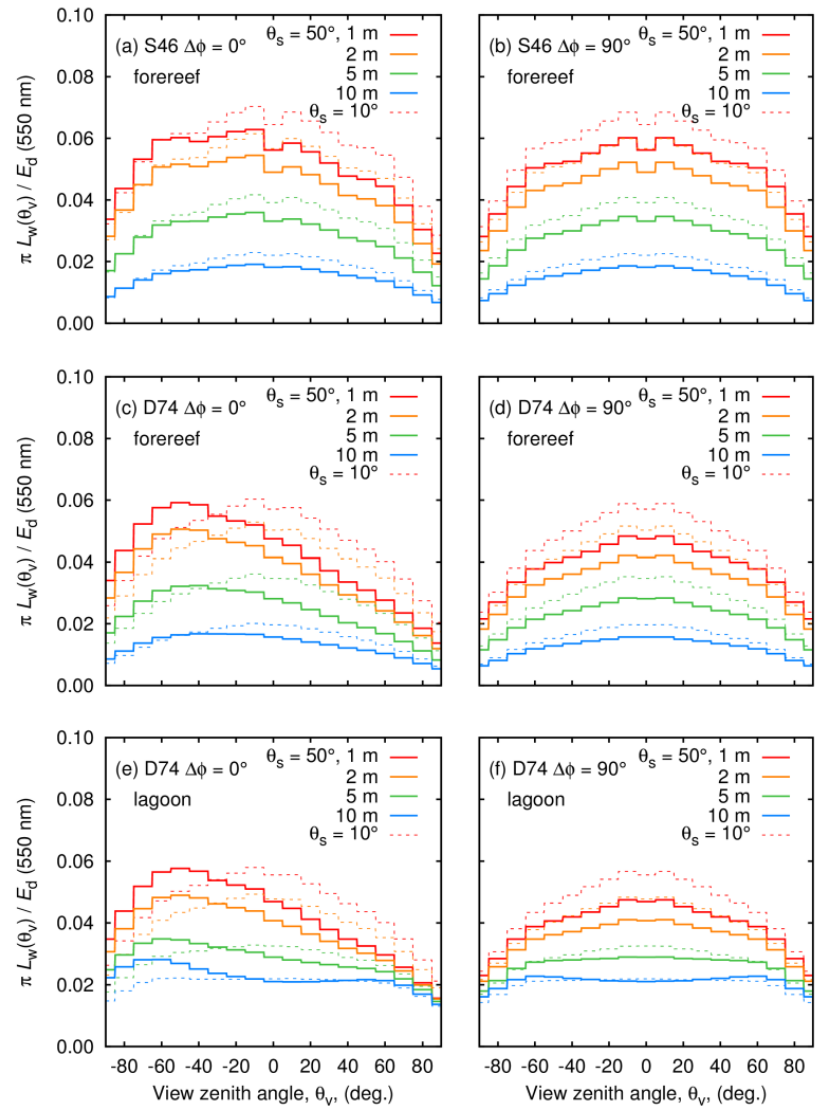
Figure 10. Modelled influence of three-dimensional coral BRDF effects (from Figure 9) on water-leaving reflectance ( π Lw/Ed) at 550 nm for: ( a , b ) Composite canopies S46 (46% shallow coral cover) and; ( c , d , e , f ) D74 (74% deep coral cover), in the incident plane ( a , c , e , ∆ ϕ = 0 ◦ ) and at 90 ◦ to the incident plane ( b , d , f , ∆ ϕ = 90 ◦ ). Each plot shows results of incident solar zenith angles of 10 ◦ (dotted lines) and 50 ◦ (solid lines), and depths 1, 2, 5, and 10 m. Negative view zenith angle for ∆ ϕ = 0 ◦ ( a , c , e ) means backward reflection (source and view point in the same hemisphere).